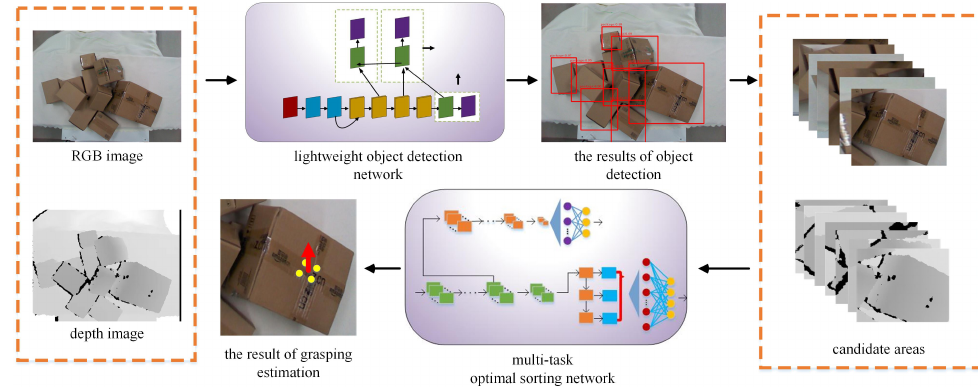
Figure 1. The overall framework of a parcel sorting method based on multi-task deep learning. A lightweight object detection algorithm is used to sense the environment, and the position and category of the express parcels are quickly and accurately obtained. An optimal sorting position and pose estimation network model based on multi-task deep learning are used to estimate the location and attitude for the grasping of the